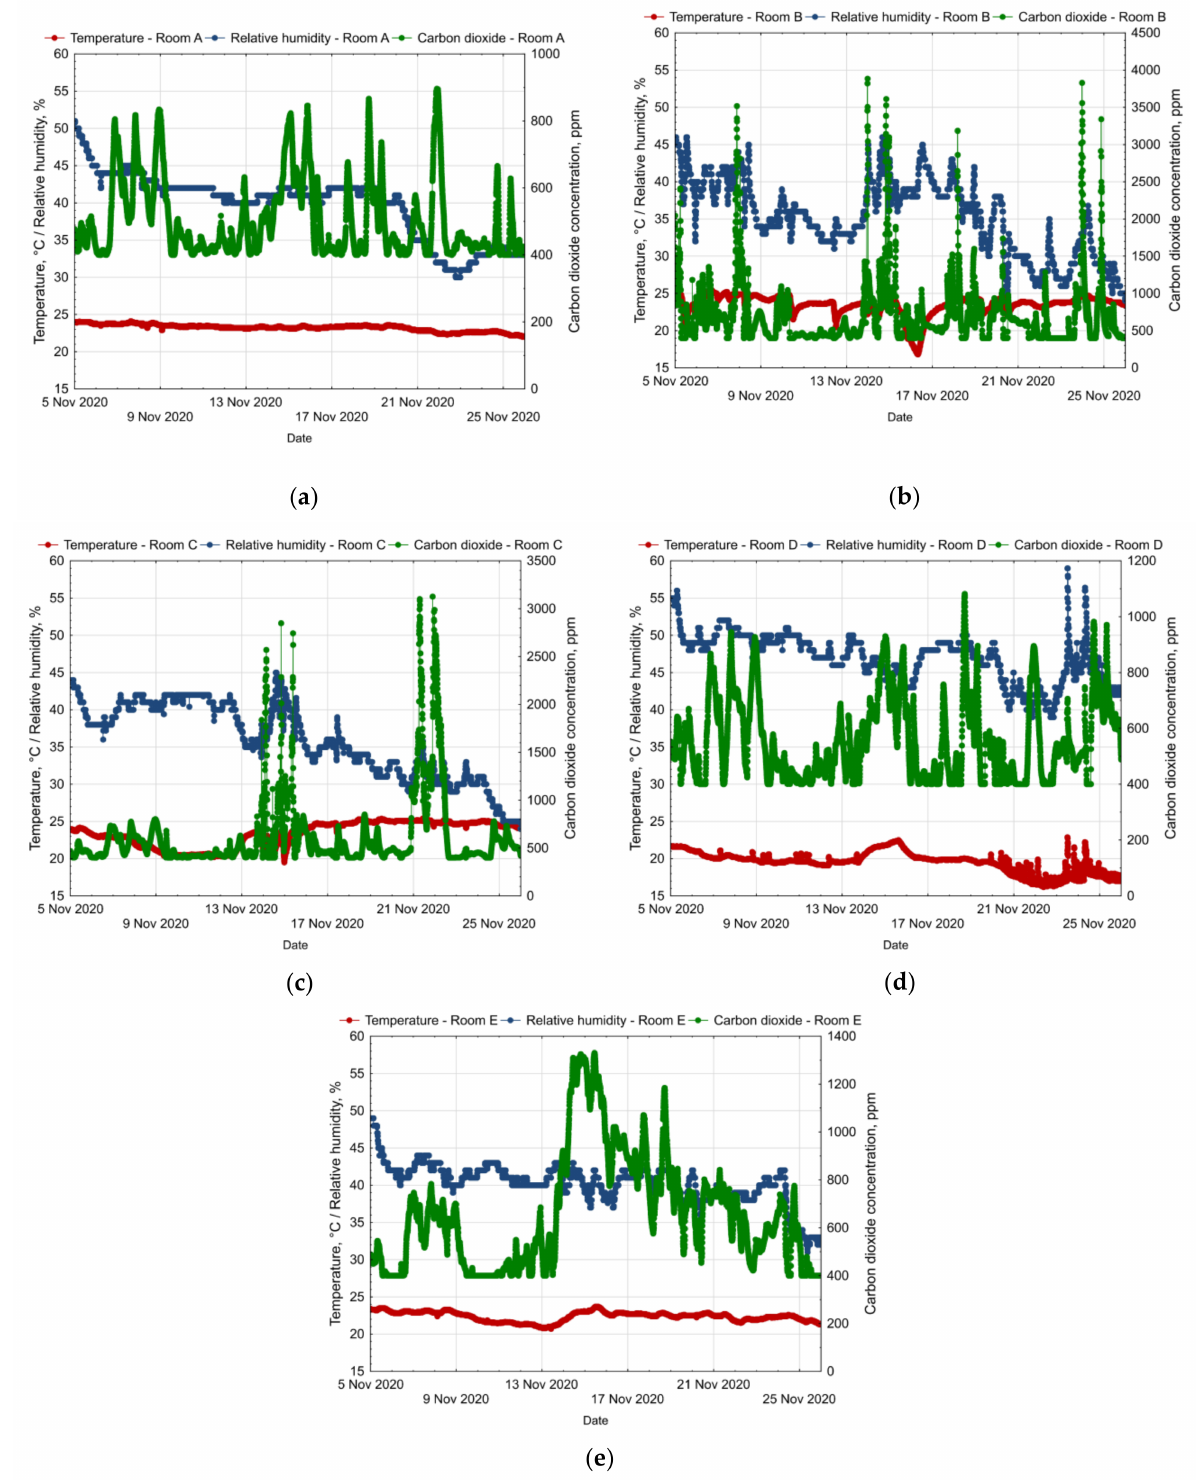
Figure 4. Variability distribution of the temperature, relative humidity, and carbon dioxide concentra- tion in each of the analyzed rooms over three weeks: ( a ) Room A; ( b ) Room B; ( c ) Room C; ( d ) Room D; and ( e ) Room